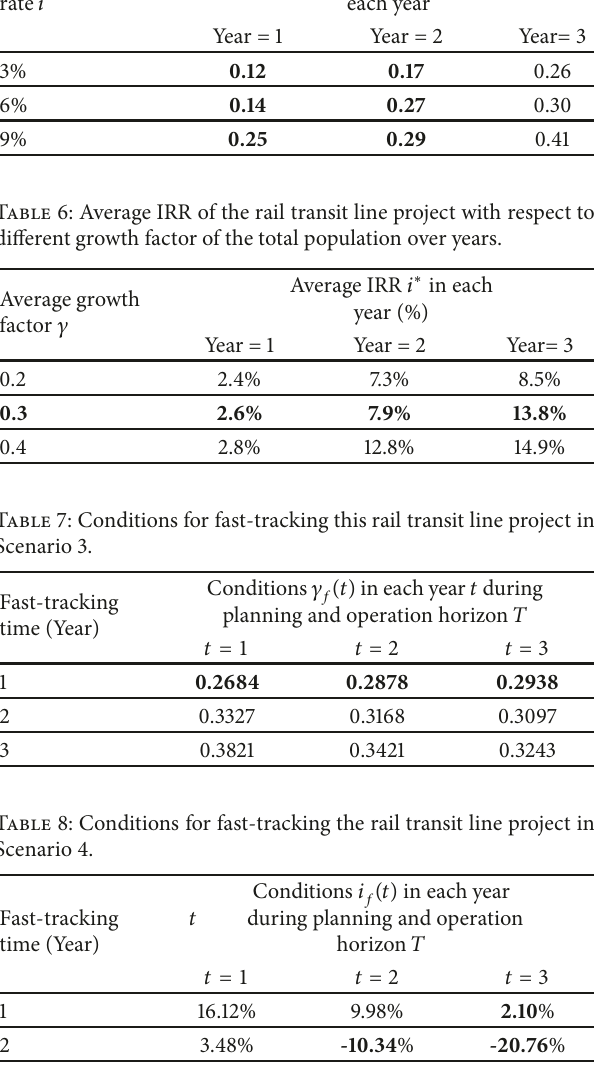
Figure 3: The proposed toy network.